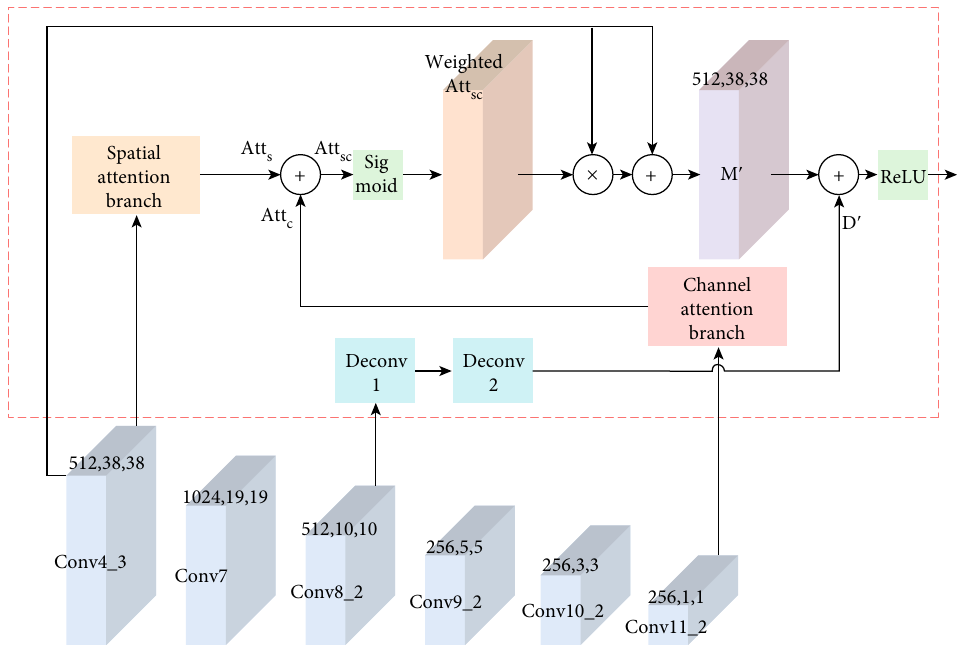
Figure 4: Multiattention module with feature fusion. The structure is the MA-FF on conv4_3 layer. In practice, the output of Deconv-1 adds with conv7, and the output of Deconv-2 adds with conv4_3. + means the symbol of element wise add operation, and × means the corresponding element multiply